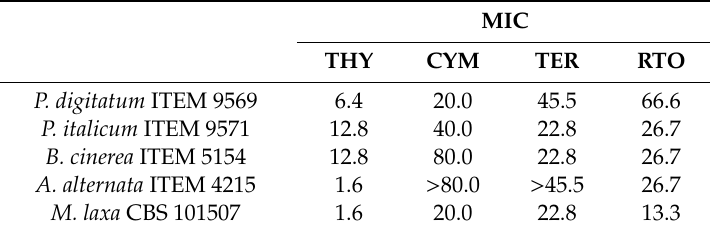
Table 2. Minimum inhibitory concentration (MIC) of single RTOCs ( µ g / L) or commercial RTO ( µ L / L, diluted in n-hexane at 50% v / v ) able to produce a reduction (%) in fungal biomass higher than 20% after exposure to vapors for 72 h at 25 ◦